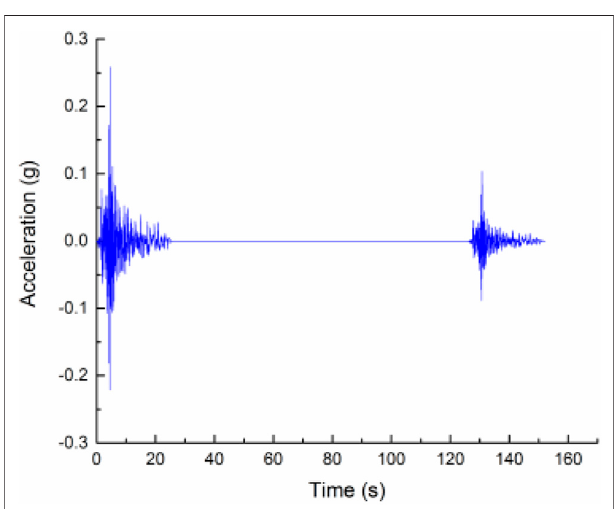
FIGURE 5 | Acceleration time-history curves of mainshock-aftershock sequences (C08 – 320, PGAMS (cid:2) 0.259 g).